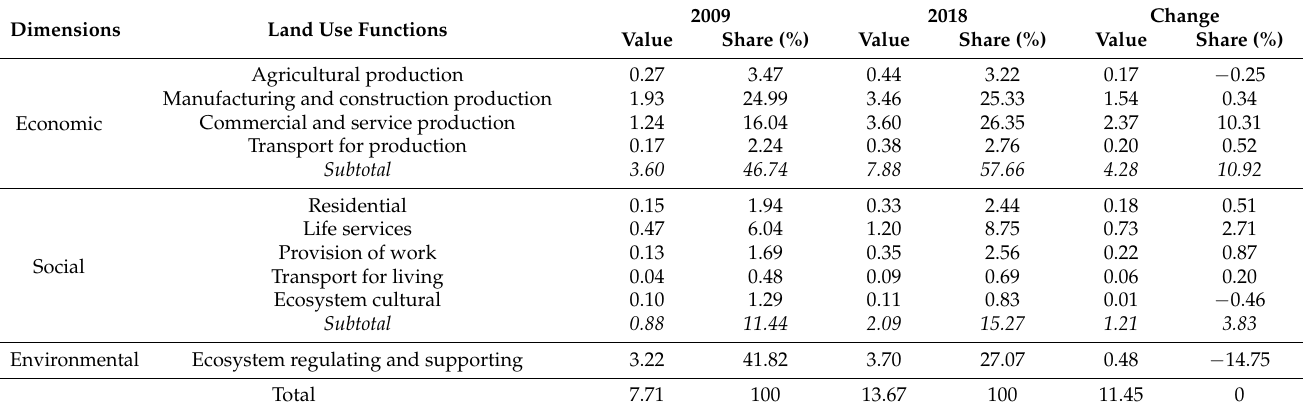
Table 3. Land use functional value (unit: trillion yuan) and share of Shandong